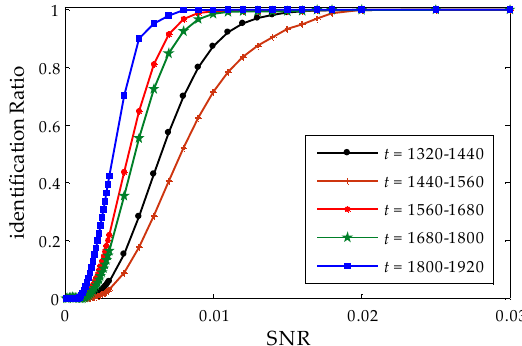
Figure 8. The identification result with different signal-to-noise ratio (SNR).